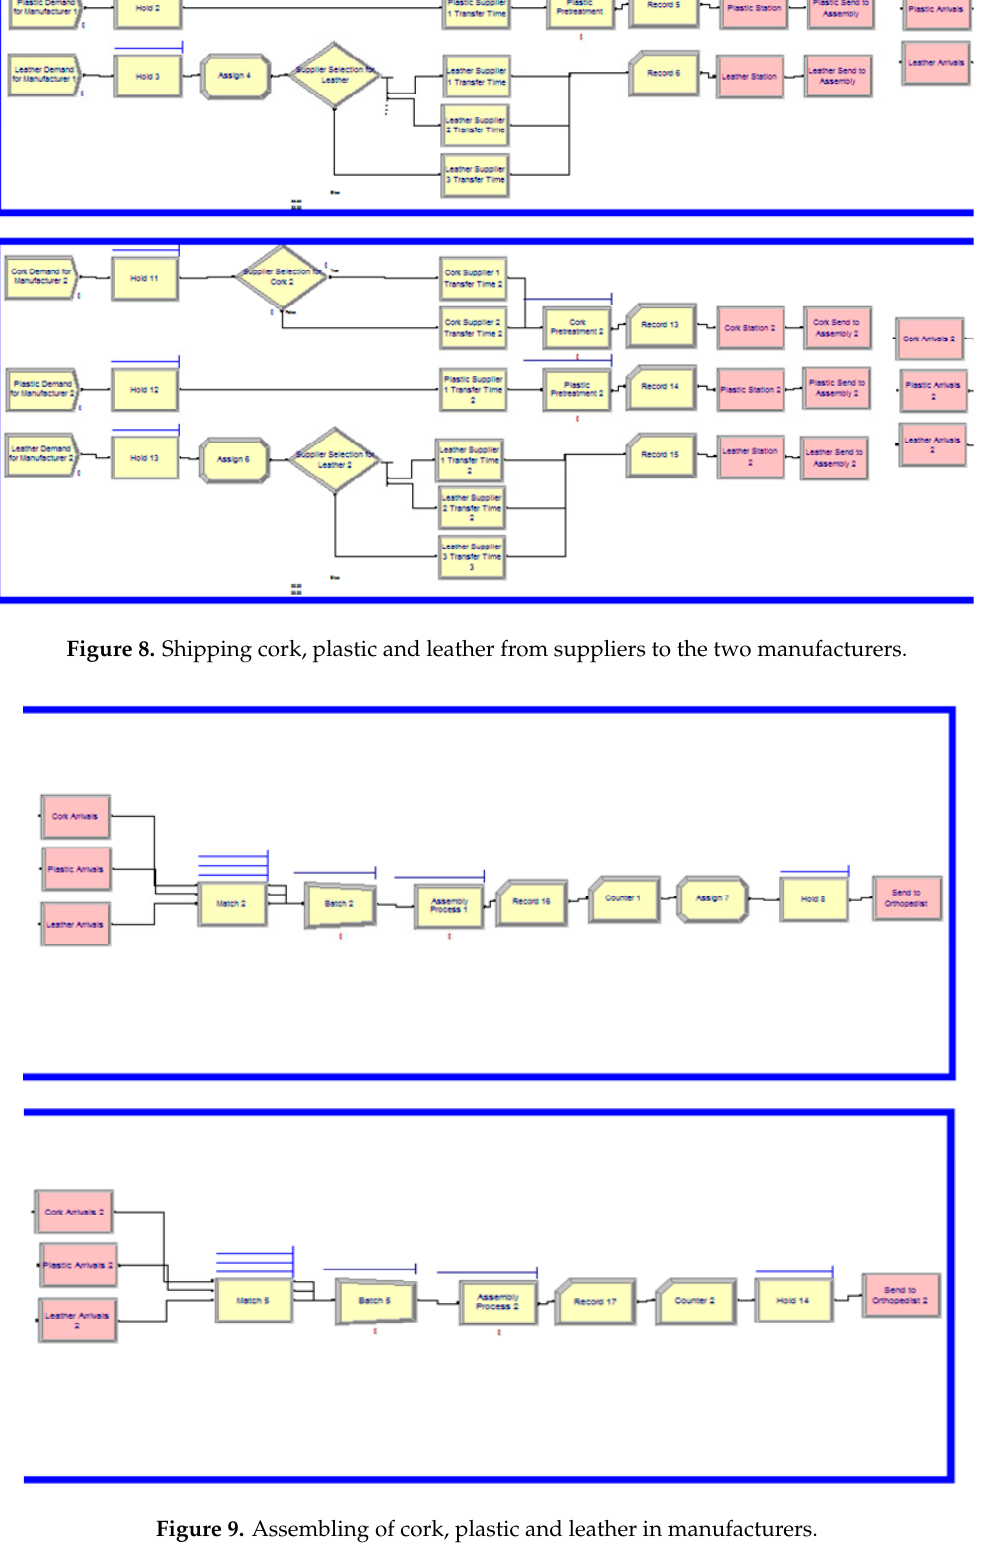
Figure 10. First testing of insole and adjustments in the office of orthopedist. Figure 11. Re-manufacturing operations in the manufacturers if necessary.